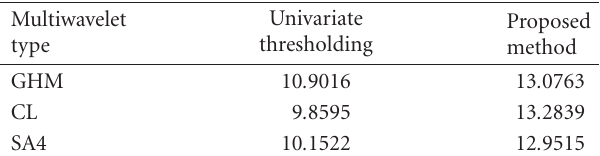
Figure 5: HH subband corresponding to a single-level multiwavelet decomposition.